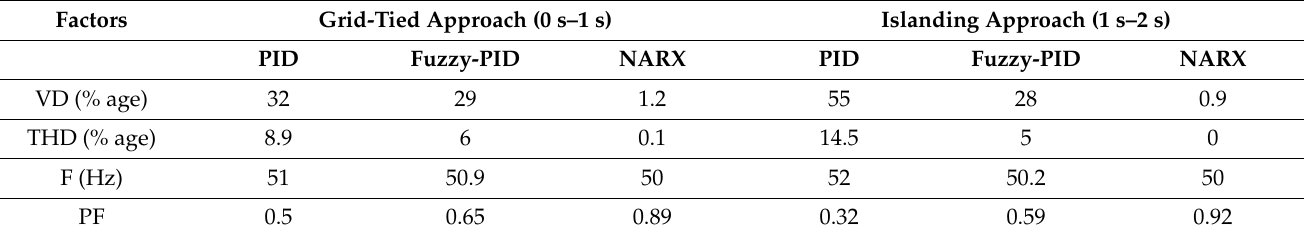
Table 6. PID, Fuzzy-PID, and NARX-NN controller